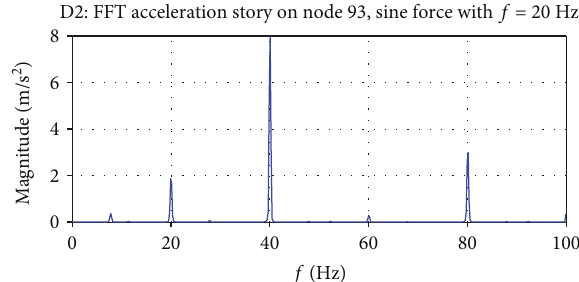
Table 3: D2, superharmonic contributions, sine excitation tests. superharmonic